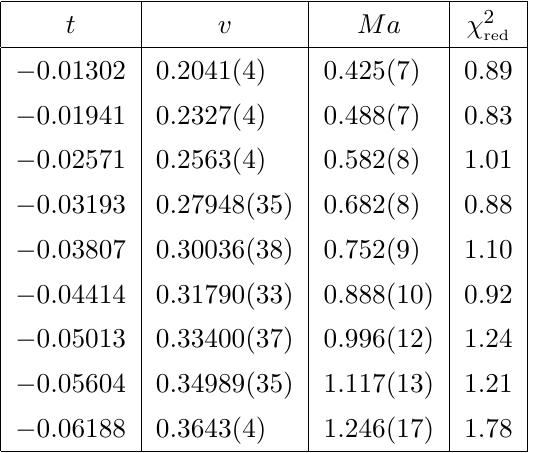
Table 2 . Results for the fits of our numerical results for the spin profile, from simulations with L/a = 90 and R/a = 20 , to eq.